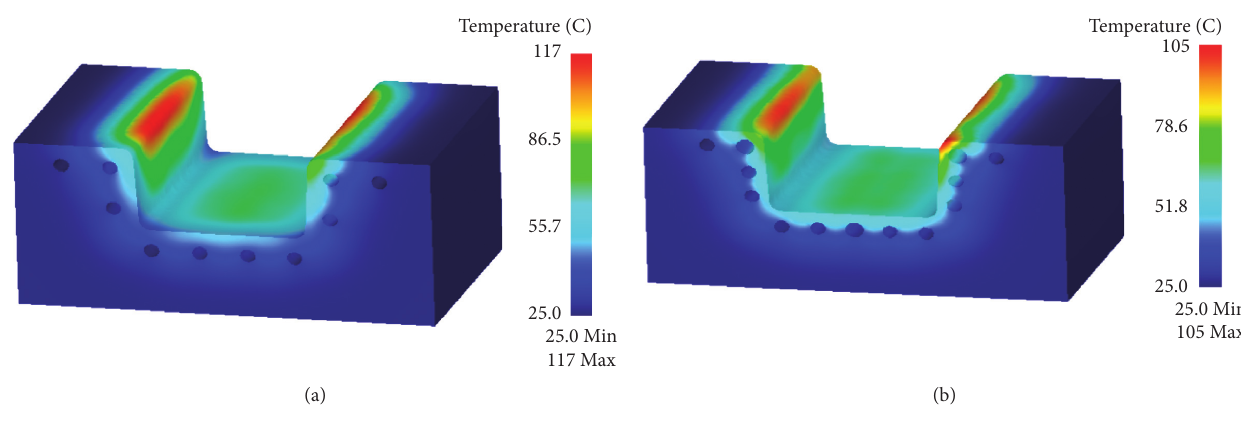
Figure 7: Parameter optimization of the cooling channels in